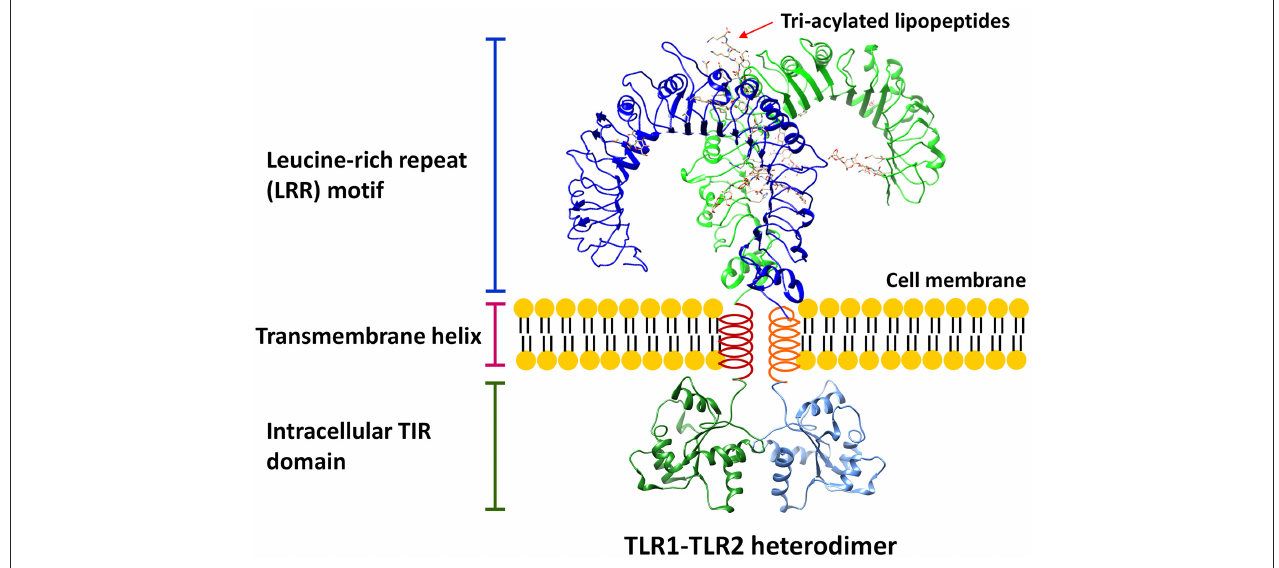
FIGURE 1 | A representative structure of TLR. The conserved structural features of all TLRs consist of three critical components: (1) leucine-rich repeat (LRR) motif; (2) transmembrane helix; (3) intracellular TIR domain. The LRR structure is based on the model of TLR1-TLR2 heterodimer (Protein Data Bank, PDB, ID: 2z7x) interacting with 6 tri-acylated lipopeptides, Pam3CSK4, whereas the TIR domain homology model is based on TLR2 TIR structure (PDB ID: 1fyw).